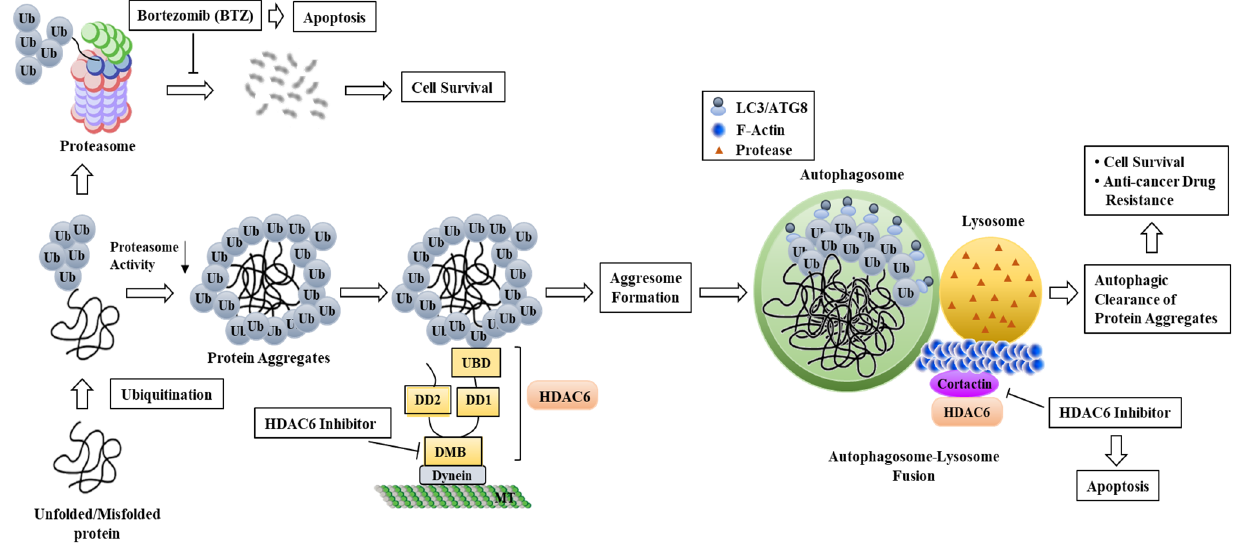
Figure 6. Role of HDAC6 in autophagic clearance of protein aggregates. Unfolded and/or misfolded proteins are ubiquitinated and taken into proteasome for degradation. Inhibition of proteasome activity by bortezomib (BTZ) leads to formation of abnormal proteins. Accumulation of abnormal proteins leads to apoptotic cell death. Aggresome formation occurs when proteasome cannot further process unfolded and/or misfolded proteins. HDAC6 loads ubiquitinated protein aggregates (misfolded and/or unfolded) onto dynein motor protein for transport to aggresome for autophagic clearance. HDAC6 inhibition prevents fusion of autophagosome with lysosome, leading to accumulation of protein aggregates and resulting in apoptotic cell death. Autophagic clearance of protein aggregates leads to cancer cell survival and confers anti ‐ cancer drug resistance. DD1 and DD2 are catalytic domains of HDAC6; Ub denotes ubiquitin; UBD denotes ubiquitin binding domain; DMB denotes dynein motor binding domain; MT denotes microtubule; F ‐ actin denotes actin filaments; and ↓ denotes negative regulation.